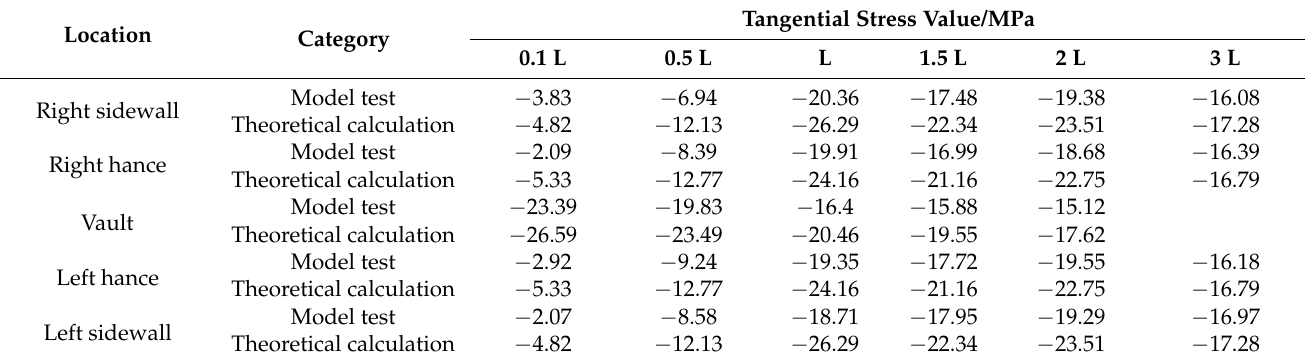
Table 5. Tangential stress around the